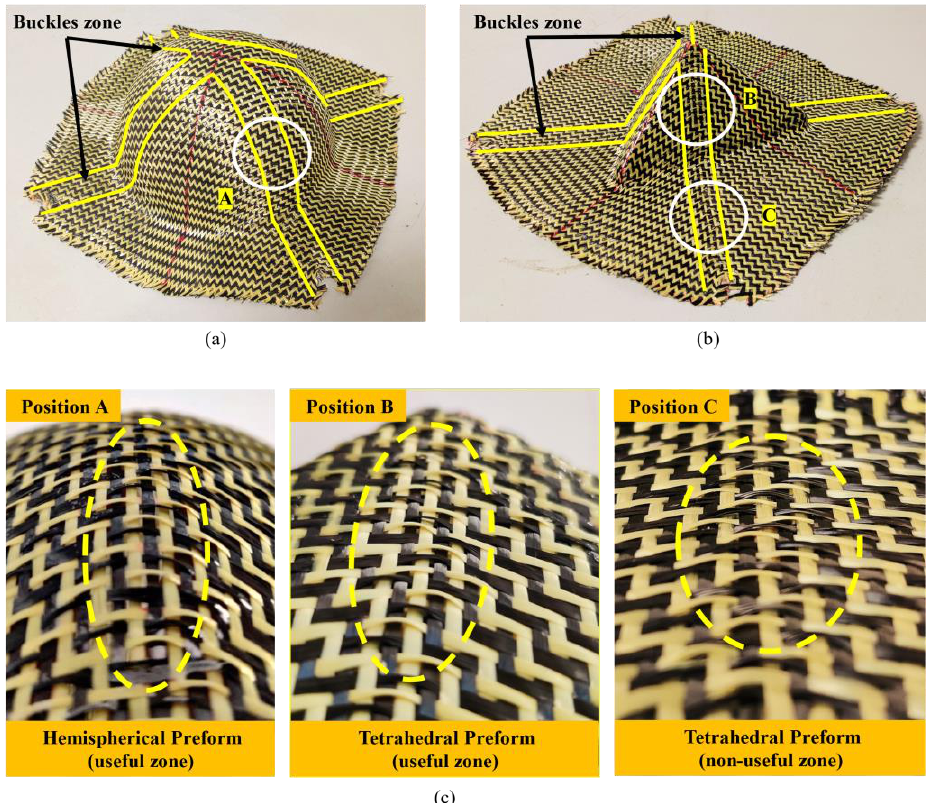
Figure 16. Out-of-plane yarn buckling in the preform and its location. Located near the central warp and weft yarn: ( a ) buckles zone on tetrahedral preform; ( b ) buckles zone on hemispherical preform; ( c ) zoom of the buckles.